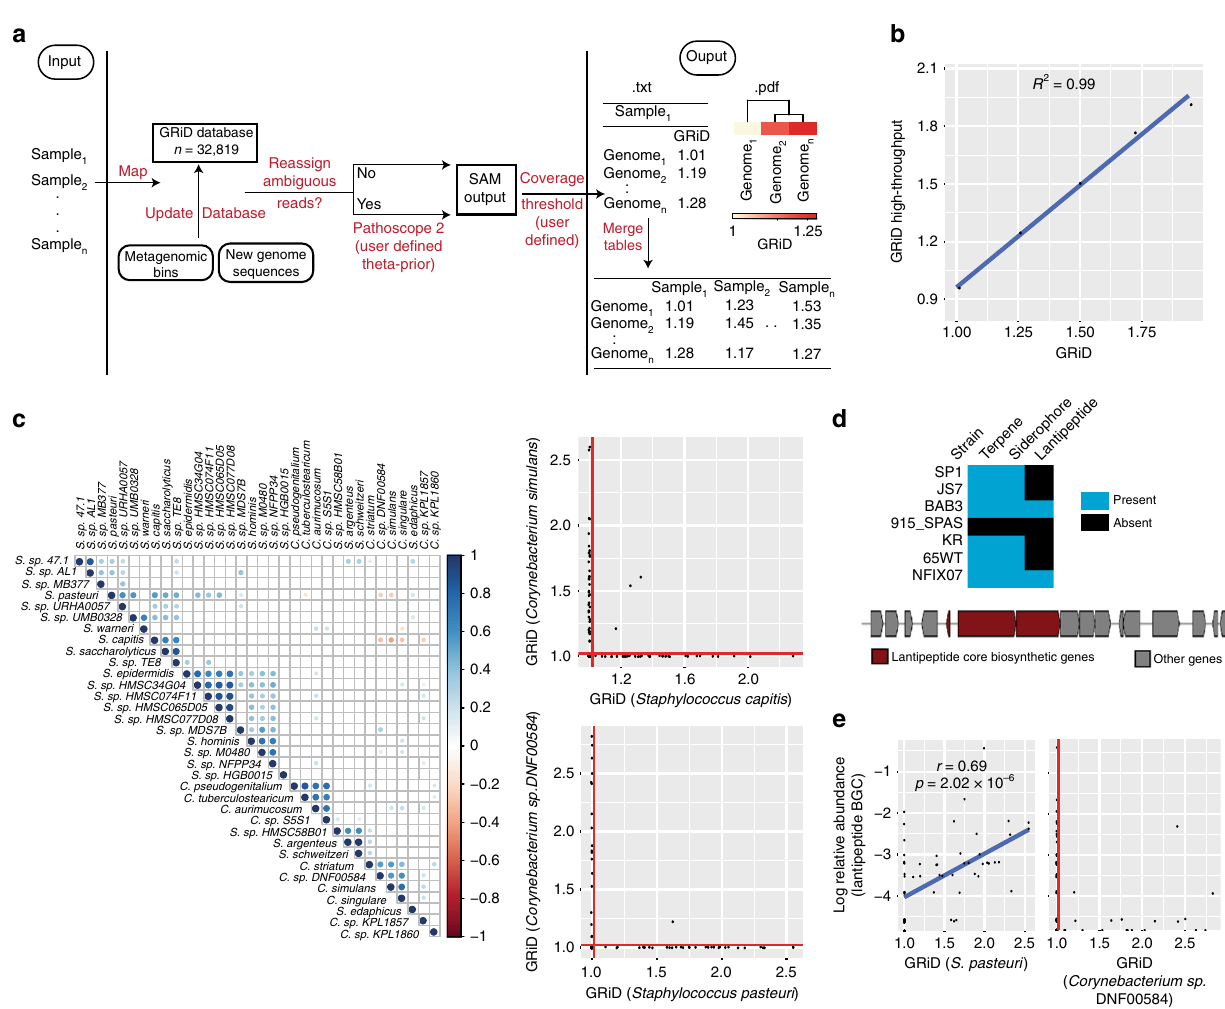
Fig. 3 GRiD-MG for high throughput, multiplex estimations of growth rate. a Pipeline for GRiD-MG. Sample reads from a dataset are mapped to a GRiD- MG database. The database can be updated using metagenomic bins or newly sequenced genomes. Two output fi les are generated for every sample; a text fi le of genomes and their respective GRiD values, and a pdf fi le displaying heatmap of growth values with hierarchical clustering. b Correlation between GRiD-MG and GRiD values obtained using single isolate genomes. Mock reads were generated for 5 genomes for growth analyses. c Growth rate correlation between bacterial species in foot sites. Blue and red circles indicate positive and negative Spearman correlation respectively. Larger circles and darker colors indicate a higher correlation. The plot on the right represents competitive exclusion between Staphylococcus and Corynebacterium species. Microbes with GRiD score below 1.02 (vertical and horizontal red lines) were considered as non-replicating. d Biosynthetic gene clusters (BGC) identi fi ed in genome sequences of S. pasteuri strains retrieved from NCBI. The fi gure below shows a lantipeptide BGC identi fi ed in strain BAB3. All BGCs were predicted using antiSMASH 30 . e Spearman correlation between S. pasteuri growth rate and the relative abundance of its lantipeptide BGC. The fi gure on the right shows the effect of S. pasteuri lantipeptide BGC abundance on growth rate of Corynebacterium sp . GRiD scores below 1.02 (red vertical line) are considered as non-replicating. Source data are provided as a Source Data fi Methods nucleotide is derived. GRiD then calculates coverage drops across a 10 Kb window and outlier points (i.e. values below Q1 – (1.5 × IQR) and above Q3 + (1.5 ×IQR); GRiD approach . GRiD measures the growth rate of uncharacterized bacteria or where Q1 and Q3 are the fi rst and third quartiles, respectively, while IQR is the bacteria with draft quality genomes from metegenomic samples. GRiD is designed interquartile range) are excluded. A smoothing curve is then fi tted by a re- for use with a speci fi c reference genome, or in a high-throughput manner for descending M estimator with Tukey ’ s biweight function 6 . This enables the fi t to be multiplex analysis of identi fi ed bacterial population present within a sample. resistant to noise arising from species heterogeneity and low coverage. GRiD values The GRiD algorithm is based on the principle that most bacteria harbor a represent the coverage ratio of the peak and trough of the curve, in which case, circular chromosome that is replicated bi-directionally from the origin of GRiD values are directly proportional to growth rate. replication ( ori ) to the terminus ( ter ) region 4 . Therefore, a rapidly dividing Generally, coverage information derived from a sample containing multiple bacterium at any given time will have more copies of DNA close to the ori in diverse strains can be prone to noise, which will invariably have an impact on comparison to the ter . accurate growth estimates. In other words, core regions of genomes will have Reads from a metagenomic sample are fi rst mapped to a given genome unusually high coverage compared to accessory regions. Similarly, microbes (including metagenomic bins or draft genome) and the mean coverage of each present at ultra-low coverage can be prone to noise due to a wider coverage contig is calculated and contigs are sorted from high-to-low coverage. The sorted distribution resulting from contigs with an average coverage of zero. To circumvent coverage information is then sequentially distributed alternatively between two these limitations, GRiD incorporates a re fi nement step. Here, for the peak coverage temporary fi les, with one of the fi les re-sorted from low-to-high coverage (Fig. 1a). value, the lowest point of expected variation of the mean value is chosen. Likewise, Both temporary fi les are then merged to produce a coverage pattern with high the upper point of variance of the trough mean is selected for the trough value coverage contigs at both extremes, while low coverage contigs located mid-region. (Supplementary Fig. 1C). The resulting growth value is called “ GRiD_re fi ned ” . This Using this sorted reordering, contigs are concatenated and coverage across each